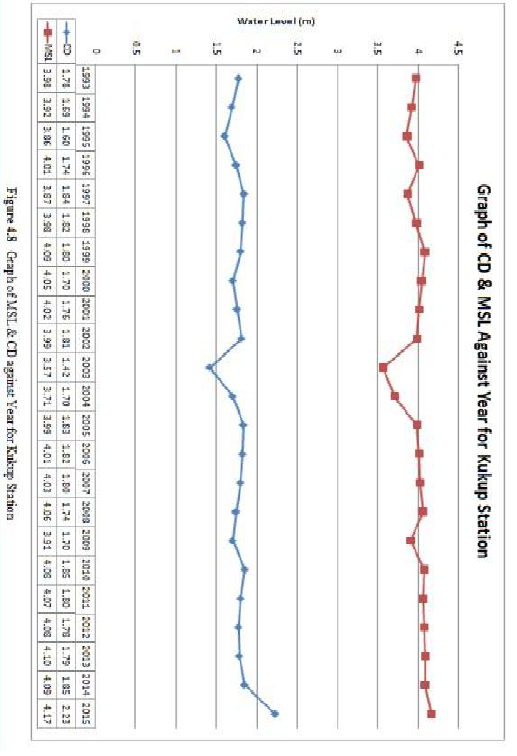
Figure 12. Penang Tide Station